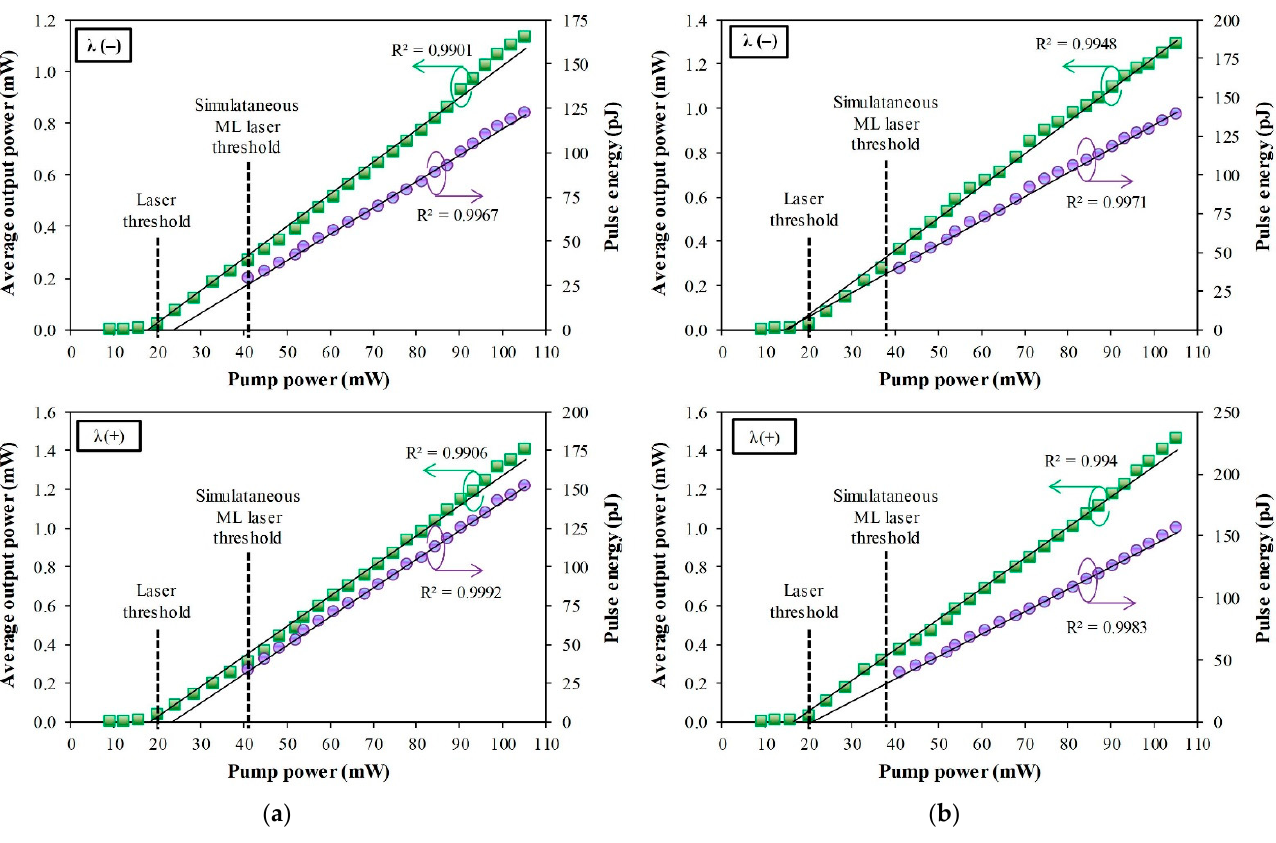
Figure 8. Average output power and pulse energy against pump power for ( a ) unidirectional DWML-EDFL and ( b ) bidirectional DWML-EDFL. Table 1. Comparison of output pulse performance for unidirectional and bidirectional